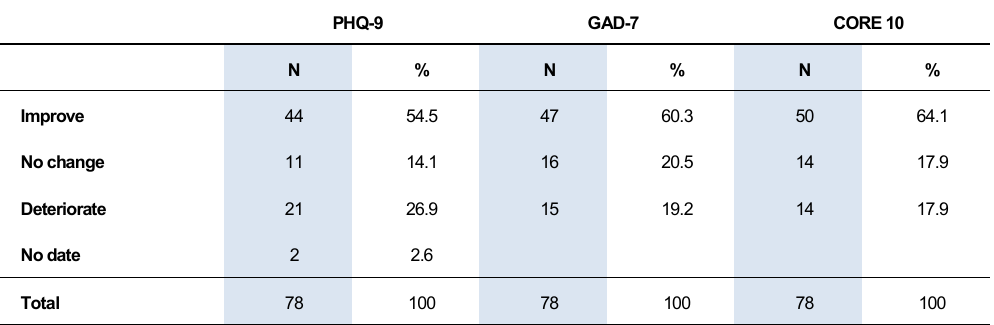
Table 5: Improvement status PHQ-9, GAD-7 and Core